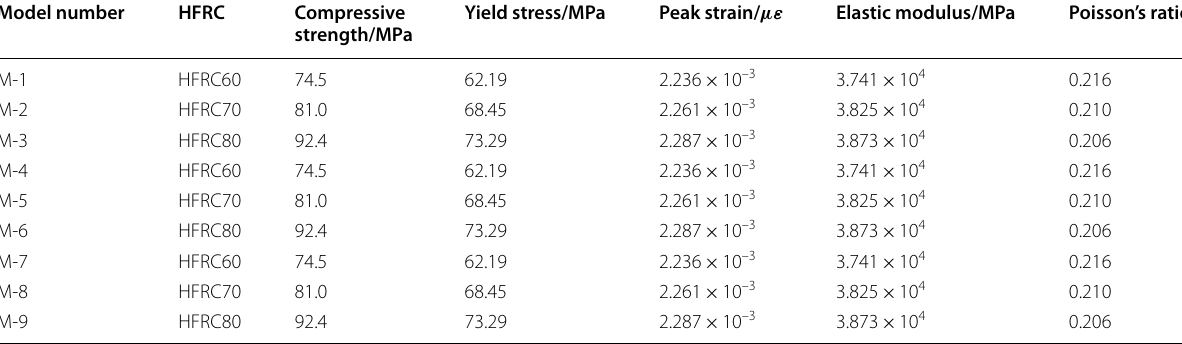
Table 6 Mechanical parameters of the shaft wall made of hybrid fiber